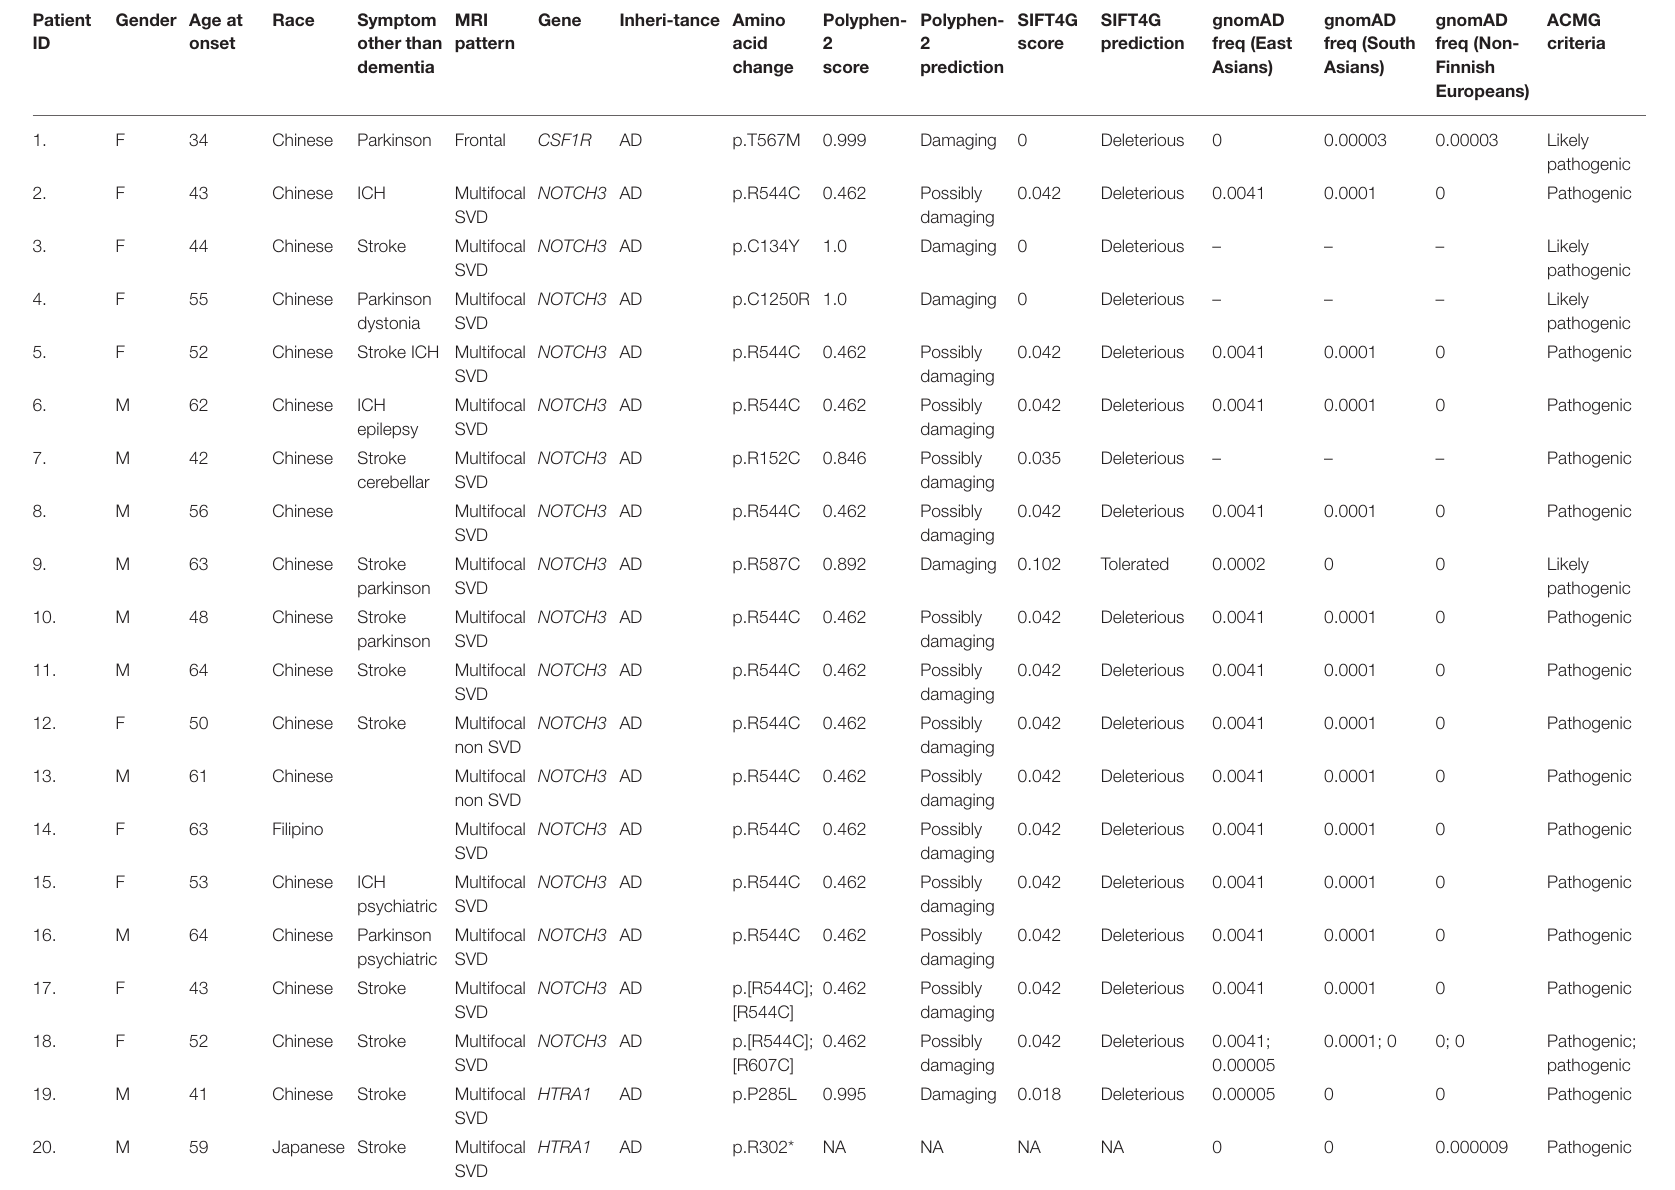
TABLE 2 | Clinical and MRI brain data of patients with pathogenic and likely pathogenic variants involving leukodystrophy-associated genes. Patient